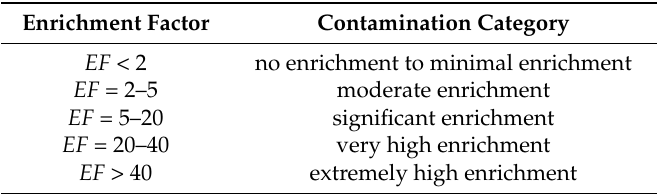
Table 1. Contamination categories based on the enrichment